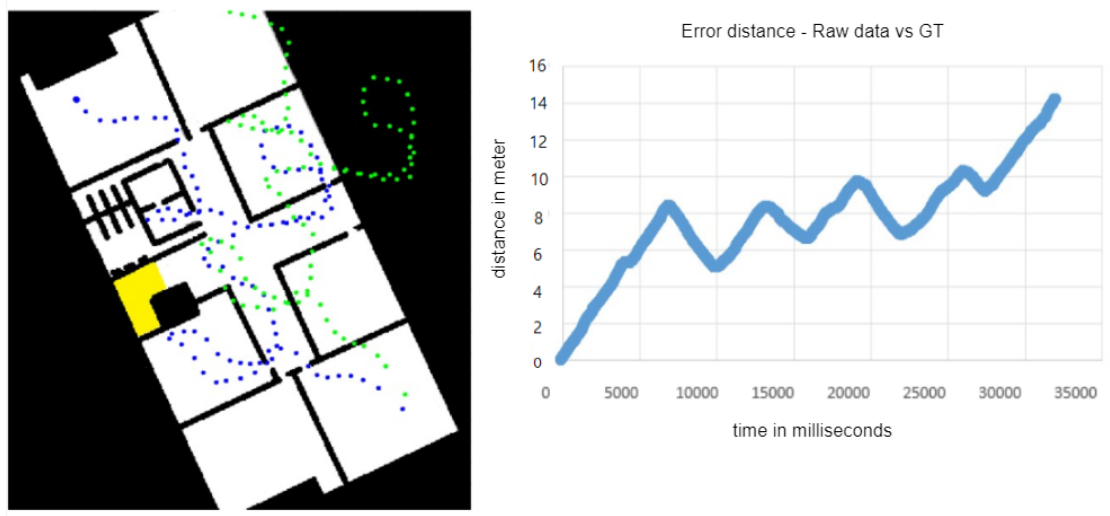
Figure 10. ( Left ): The green dots are the raw data, and the blue dots are the ground truth. ( Right ): The graph shows the error distance between them.